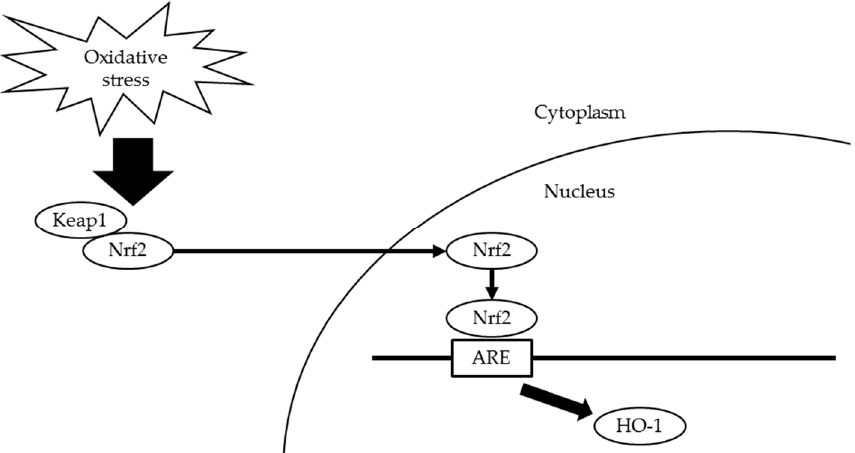
Figure 1. Scheme for Keap1-Nrf2 defense pathway. Under oxidative stress, the Keap1-Nrf2 complex dissociates and Nrf2 translocates into nuclei to bind AREs. Nrf2 activates HO-1 to attenuate cellular oxidative stress. Keap1, Kelch-like ECH-associated protein 1; Nrf2, nuclear factor erythroid 2-related factor 2; AREs, antioxidant response elements; HO-1, heme oxygenase-1.